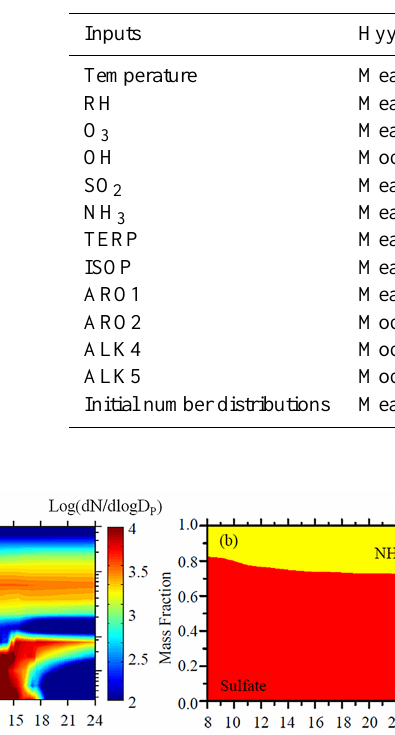
Table 1. Main inputs of DMANx simulations.